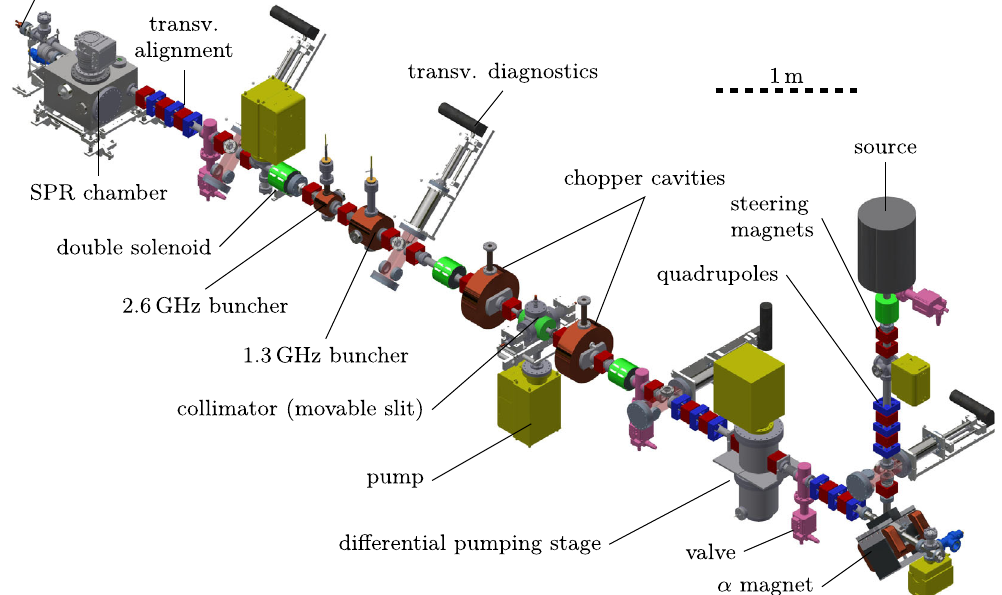
FIG. 3. Test apparatus for the injector of MESA . The DC electron beam from the source is chopped by two circularly deflecting rf cavities and an adjustable slit which cuts out a certain range of rf phases of the beam. Longitudinal compression is achieved with a system of two buncher cavities. Bunch length measurements are done in the SPR chamber. A quadrupole triplet including correction dipoles in front of the chamber provides transverse alignment of the beam.